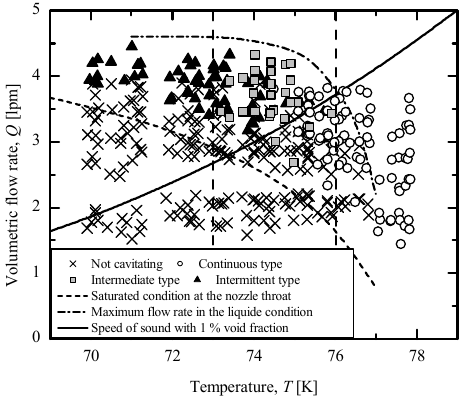
square marks indicate that of an intermediate cavitation type. The cross marks indicate the cases in which cavitation does not occur. Additional details of these cavitation behaviors are described later. A pair of broken vertical lines indicates the approximate boundary between each cavitation behavior. The volumetric flow rate required for a cavitation occurrence becomes large with a reduction in the fluid temperature. Moreover, the cavitation behavior is affected by the fluid temperature rather than the volume flow rate. The other lines in the figure are explained later.